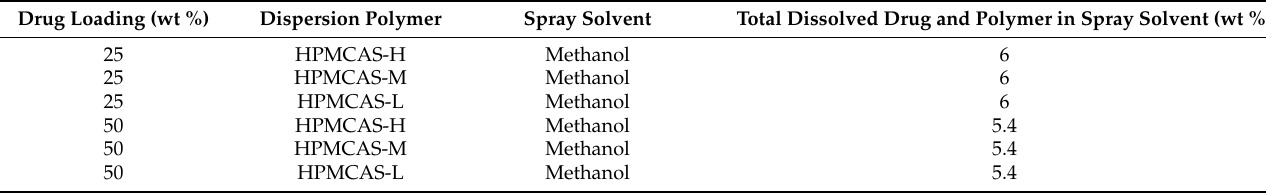
Table 1. Compositions of ASDs and spray-drying